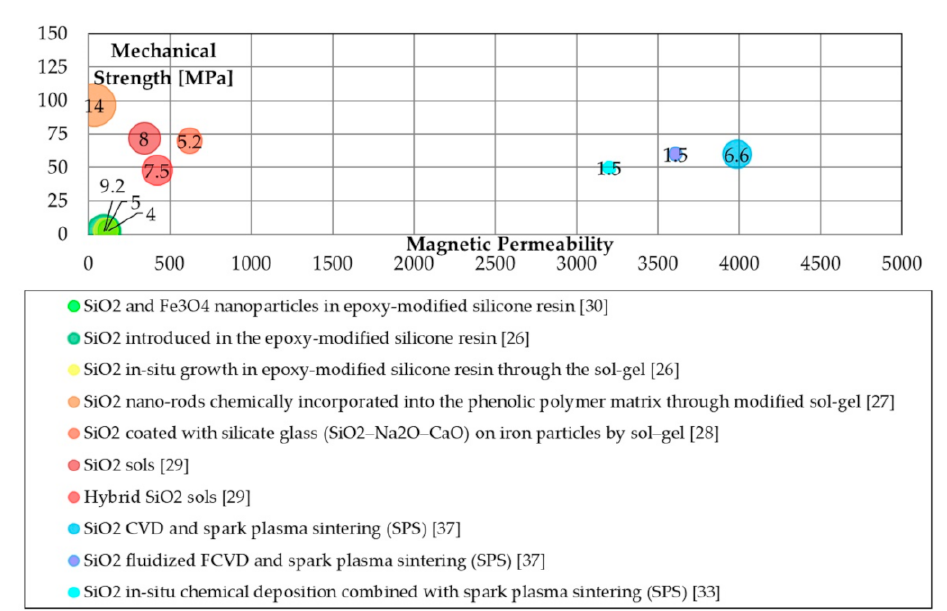
Figure 1. Magnetic (maximum permeability), mechanical (transverse rupture strength (TRS) [MPa]), and energetic properties (total iron losses 1 T@50 Hz [W/kg]) of SiO 2 coating